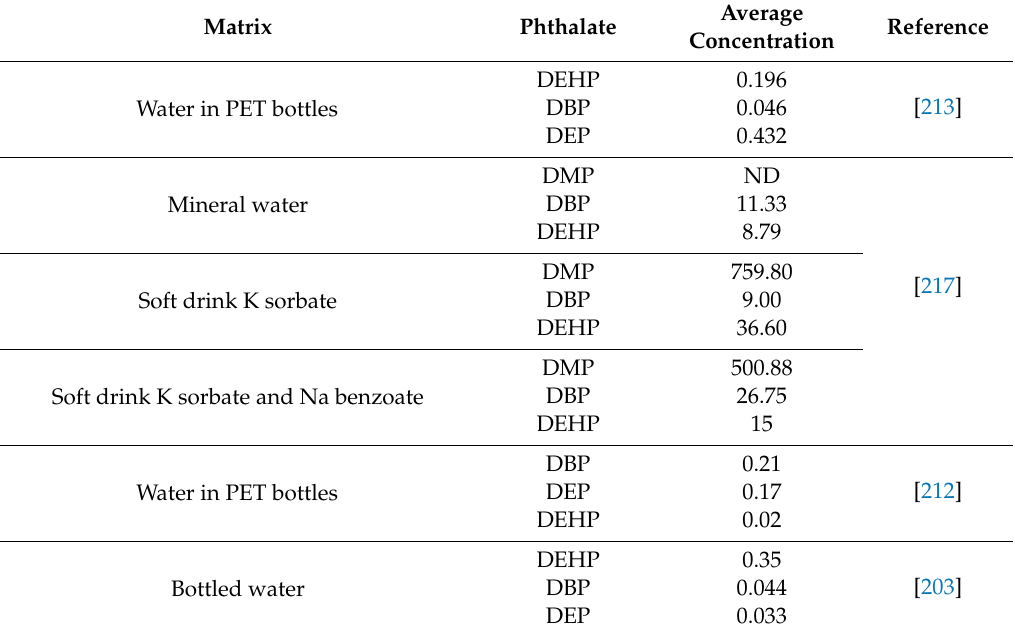
Table 4. Occurrence of phthalates in non-alcoholic beverages ( µ g L − 1